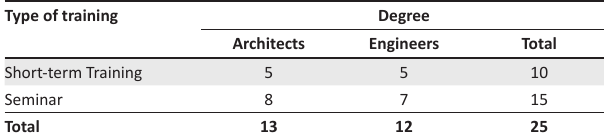
TABLE 4: Type of training.